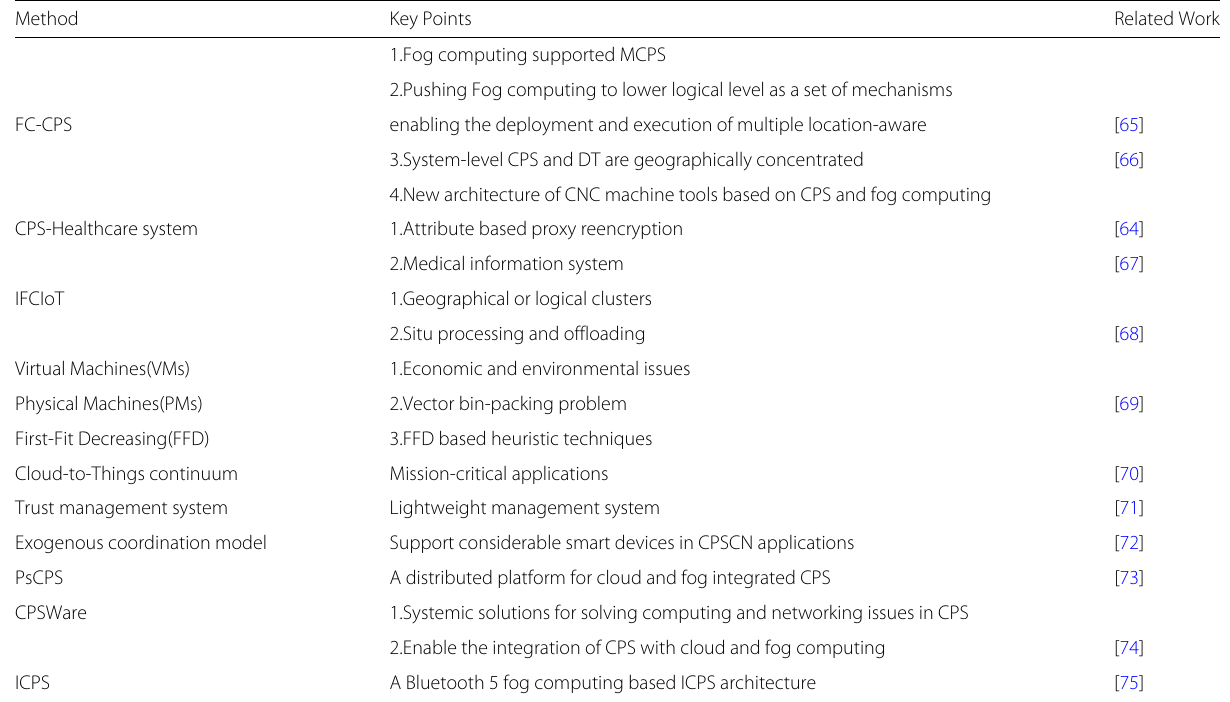
Table 4 Summary of literatures about methods on fog computing based CPS